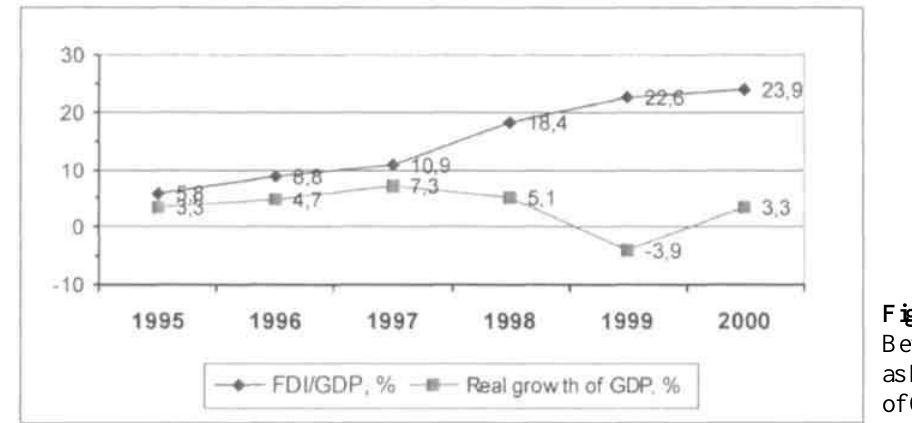
Fig 1. Analysis of Relationship Between Growth of FD1 Measured as FDI/GDP, (%) and Real Growth of GDP in Lithuania